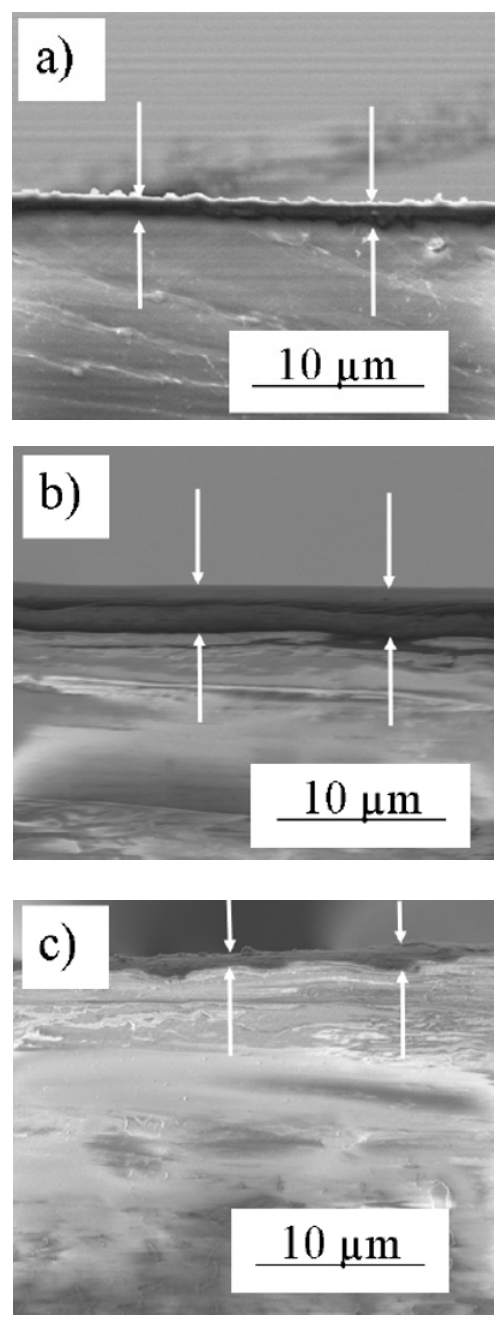
Figure 2. SEM micrographs of cross–sections of PA films with Se layers formed by the sorption-diffusion method Cu x with different duration of seleniumization. Duration of PA seleniumization, h: a) – 0.17, b) – 1.0, c) –